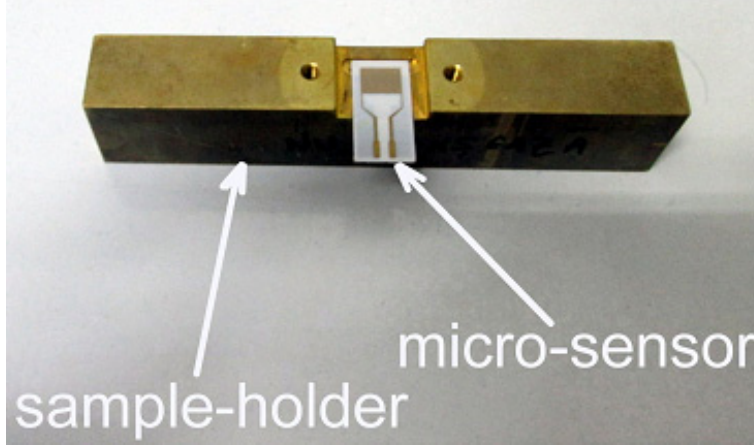
Figure 24. The sample holder with a micro-sensor in place, from ref. [126].